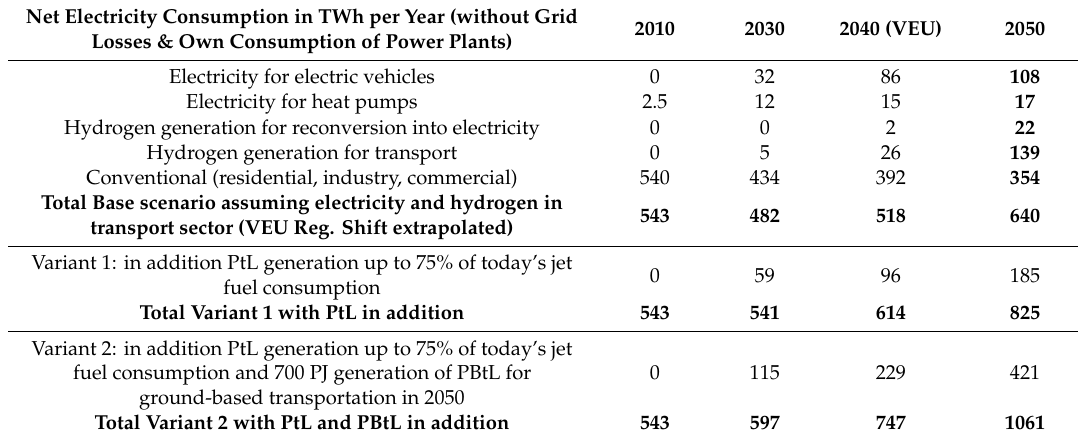
Table 3. Assumptions on the development of electricity demand in the